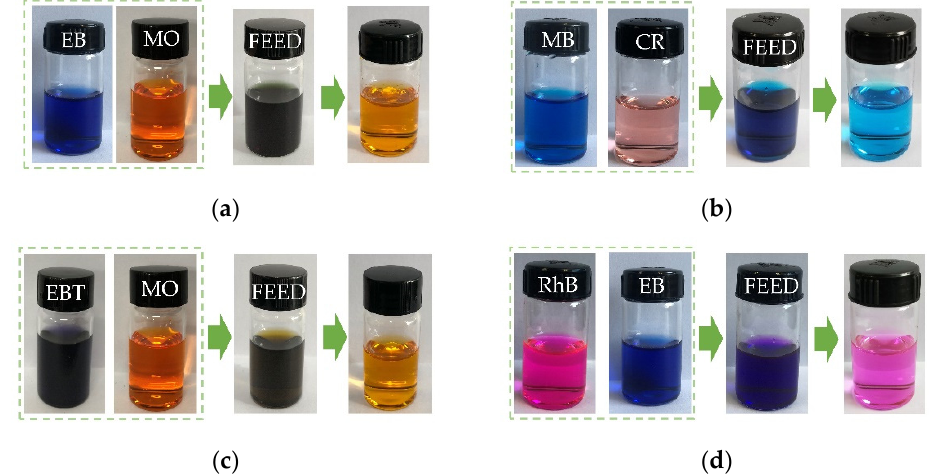
Figure 9. Samples of feed and permeate with binary dye mixtures of ( a ) EB/MO, ( b ) MB/CR, ( c ) EBT/MO, and ( d ) RhB/EB.